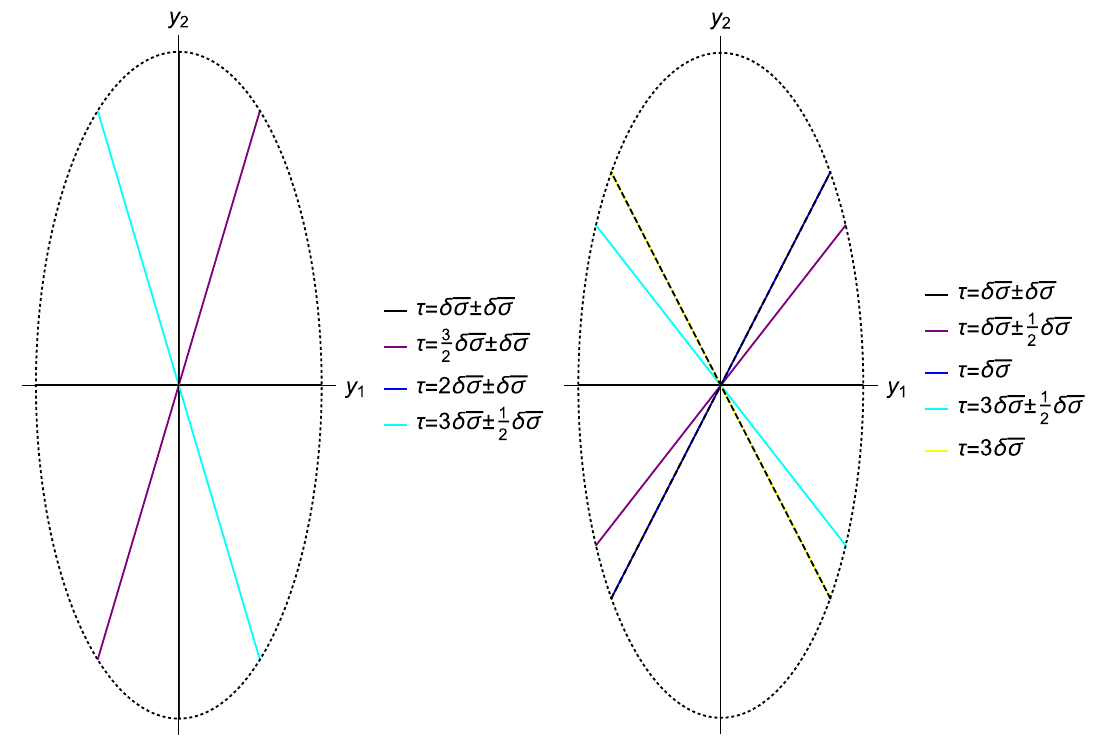
Fig. 7 Indicative translationally invariant solutions of the vectorially gauged SU ( 2 )/ U ( 1 ) model. The left panel corresponds to a rotating solution, while the right one to an oscillating solution. Notice that as λ > 0 the angle ψ of the oscillating solution “oscillates” around